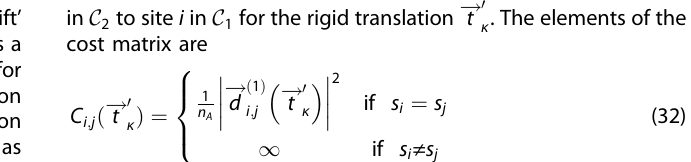
Fig. 2 Schematic of the mapping algorithm. A summary of the steps involved in generating a map between a parent structure with a square lattice and a child structure with the atoms arranged in a honeycomb pattern. Three lattice and atomic maps that relate these structures are illustrated, with the fi nal step being the evaluation of the lattice and atomic cost